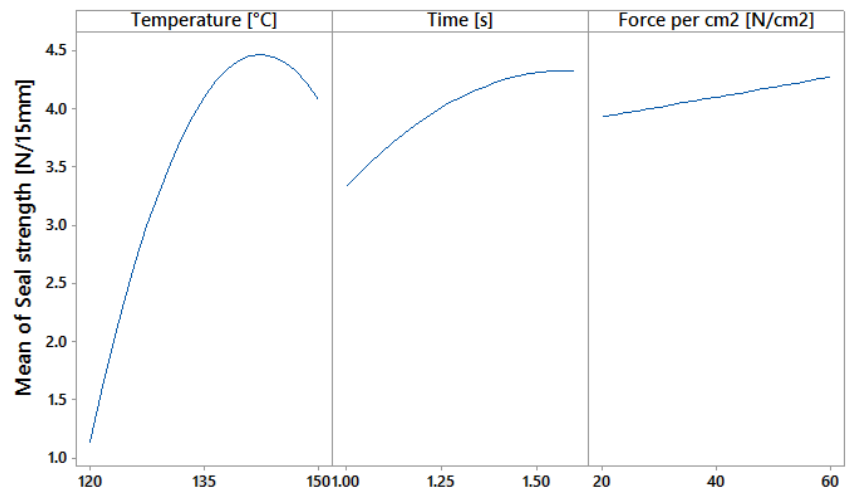
Figure 4 – Main effects plot for Seal strength, fitted means: mean of Seal strength vs. Temper- ature, Time, and Force per cm 2